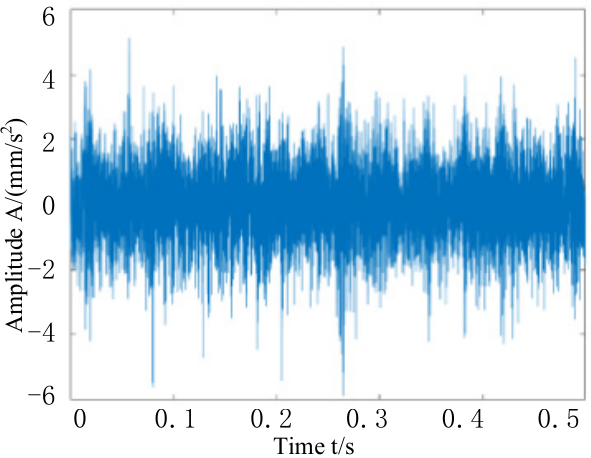
Figure 26. Filtered signal time-domain waveform.